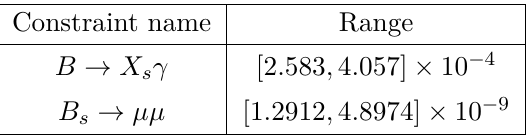
Table 2. Flavour physics constraints used in our random scan. We consider 10% uncertainty around central value as theoretical error which is added in quadrature with the experimental error to get the total error. This range is obtained by including two times this total error ( 2 σ